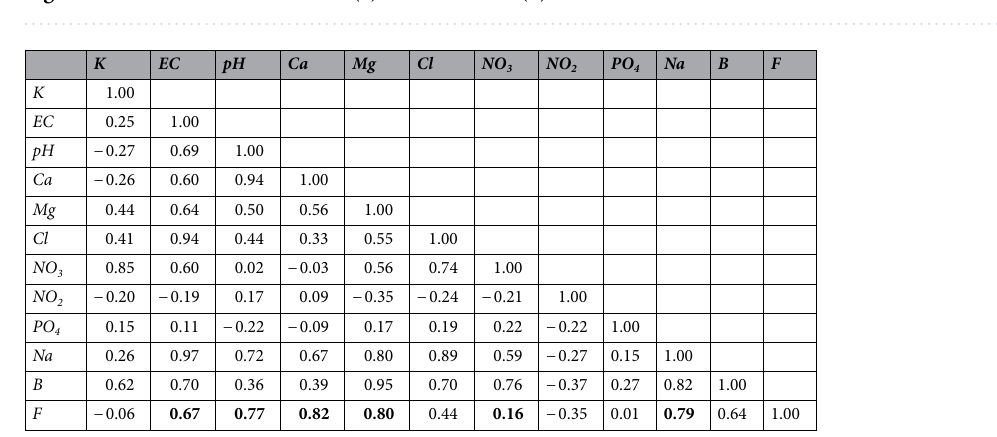
Figure 9. Fluoride concentration of ( a ) borehole 1 and ( b ) borehole 2.